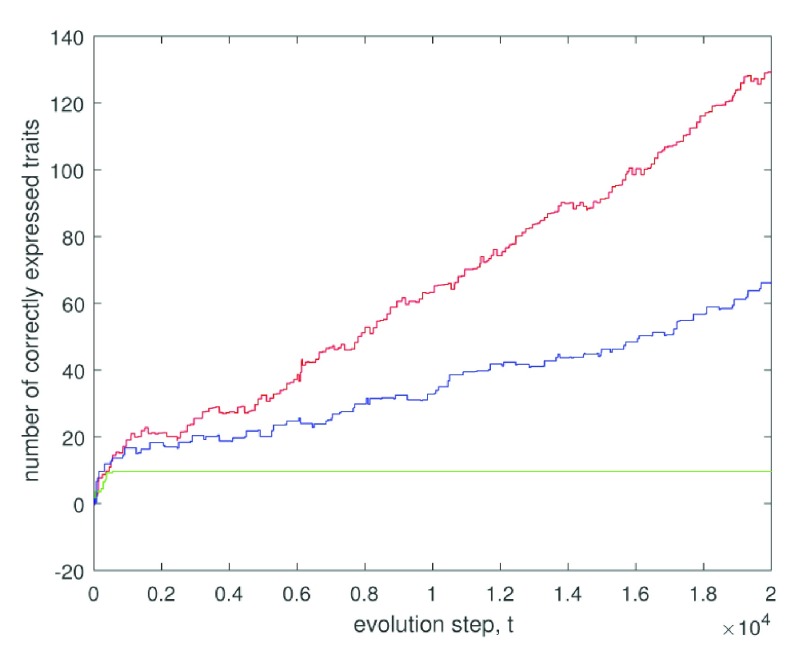
This graph shows that the modular evolution of gene regulation allows adaptation with a few genes, in that case
N
g = 10 and the number of traits
M = 200.This means that we have a very big pleiotropy. Evolution proceeds in 20000 steps. The green curve corresponds to random walk with fixed small
h without any evolution of gene regulation. We observe that with 10 genes 9 traits are correctly expressed. If evolution goes into 50 rounds then 66 traits are correctly adapted, and if evolution goes in 190 rounds then 129 traits are correctly adapted (the red curve). In that last case, at each step we make adaptation to at most one trait. Parameters are as follows. The mutation rate
p
mut = 0.01 and
K = 5. Nonzero coefficients
w
ij are random numbers distributed according to the standard normal law. The initial genome is a random binary string, where each value is 0 or 1 with probability 1/2. The coefficients
b
i are either 1 or –1, where the probability of 1 is
p
b = 0.8.